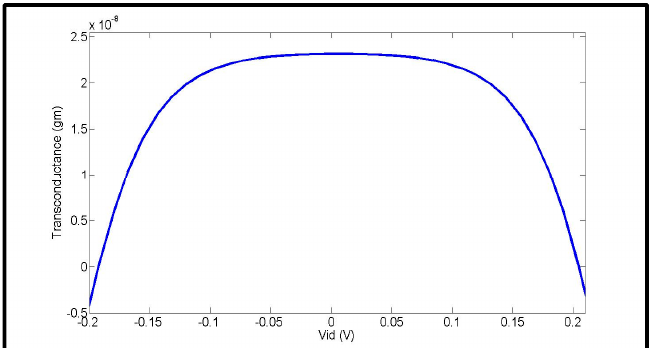
Figure 16. Transconductance plot of OTA.